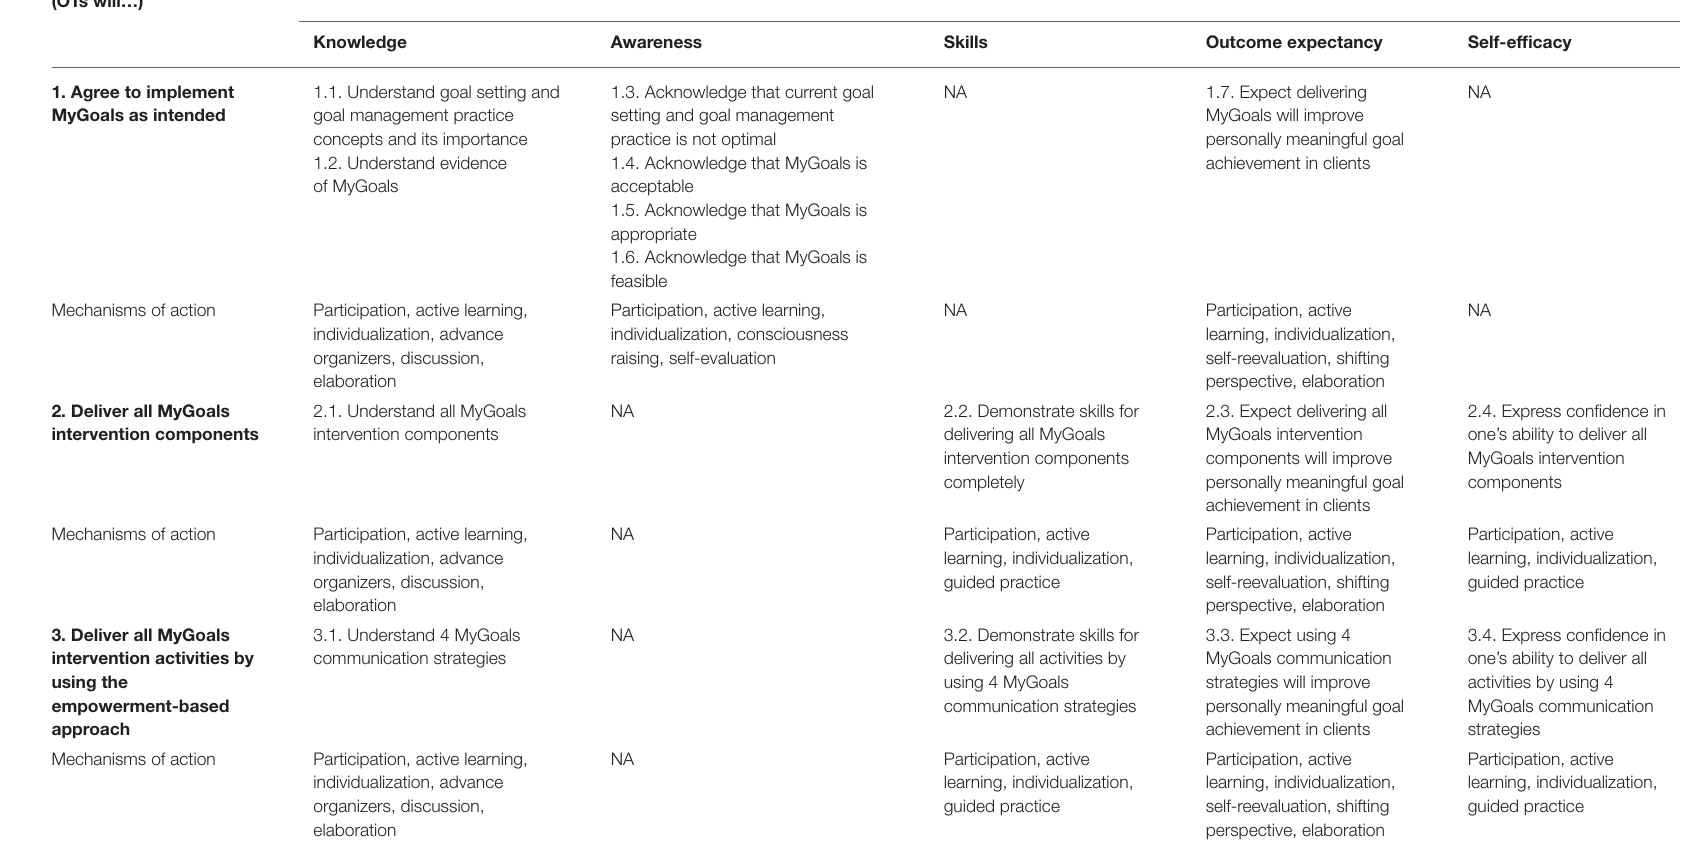
TABLE 1 | MyGoals matrices of change. Performance objectives (OTs